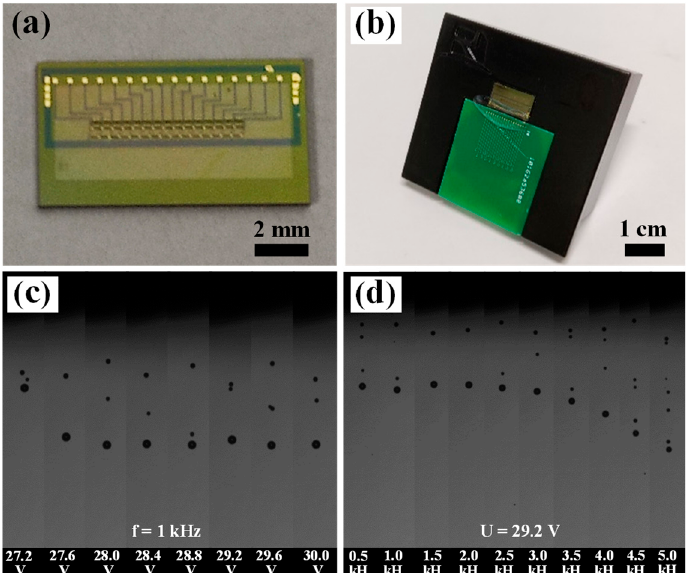
Figure 8. The optical image of ( a ) the chip and ( b ) the printhead; series of driving voltage ( c ) and jet frequency ( d ) recorded by droplet flight analysis system.